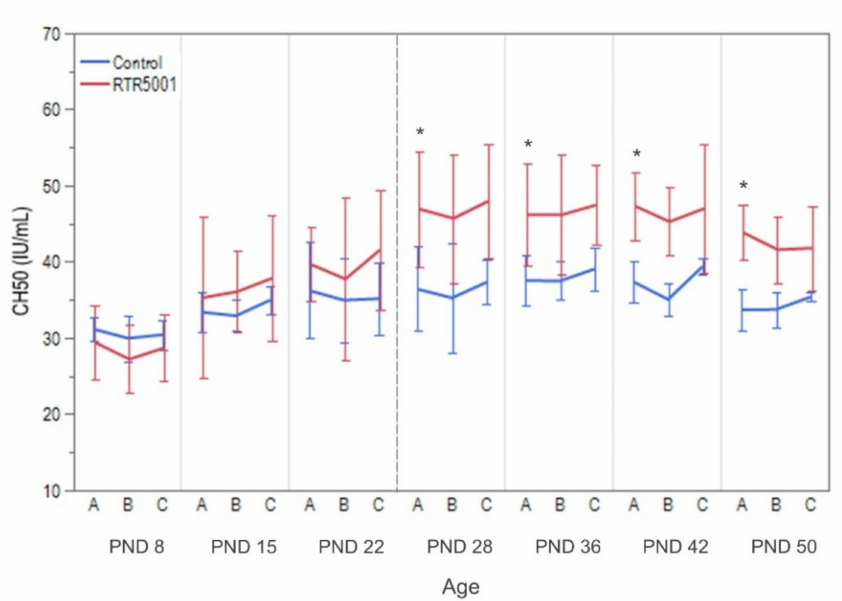
Figure 3. Mean ± SD total complement (CH50) activity measured in the serum of control and RTR5001-treated minipigs in different juvenile age groups: pre-dose (A), 15 min post-dose (B), and 24 h post-dose (C) of RTR5001. The same animals were tested (control: n = 4; RTR5001-treated: n = 4) from PND 1 until PND 28, and reduced at PND 36 and 42 (control: n = 4; RTR5001-treated: n = 3), and PND 50 (control: n = 2; RTR5001-treated: n = 2) accordingly. Broken line indicates weaning time (at PND 28) for the piglets. Differences between age, experimental groups, and their interactions before RTR5001 administration were determined using a mixed model with Dunnett’s multiple comparison tests. p value < 0.05 when compared to PND 8 control (pre-dose value) was considered significant (*). CH50 was not significantly reduced 15 min post-RTR5001 administration within each age group, but it was significantly higher for the pre-dose values of PND 28 until 50 compared to the PND 8 control group after repeated administration of